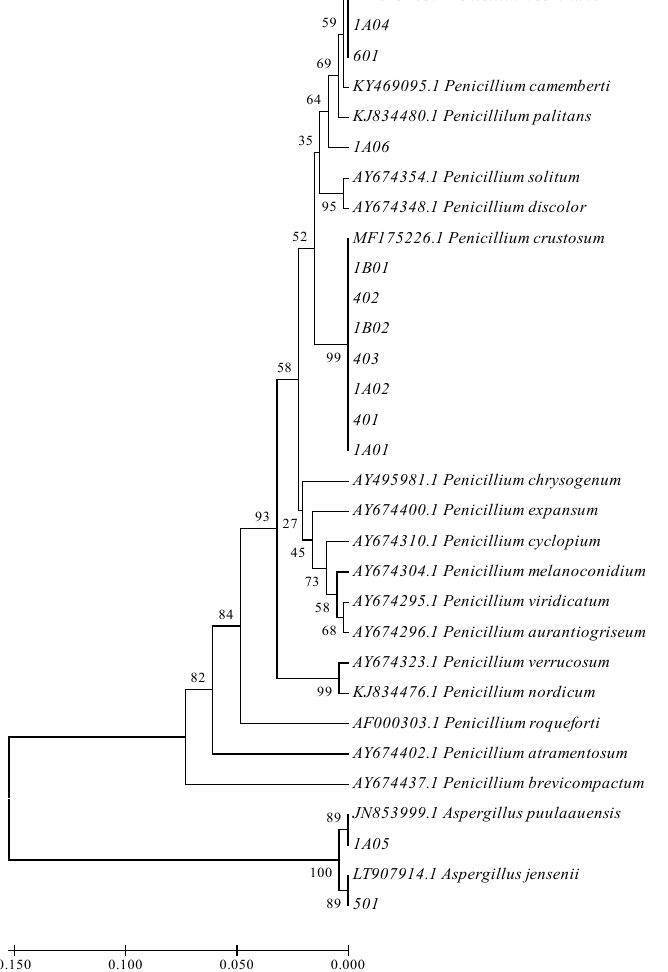
Figure 1. Phylogenetic tree obtained after UPGMA analysis of the β -tubulin BenA sequences. The accession number of the verified sequences used for comparison purposes is indicated. The percentage value of “Bootstrap” is indicated in the nodes of the branches.